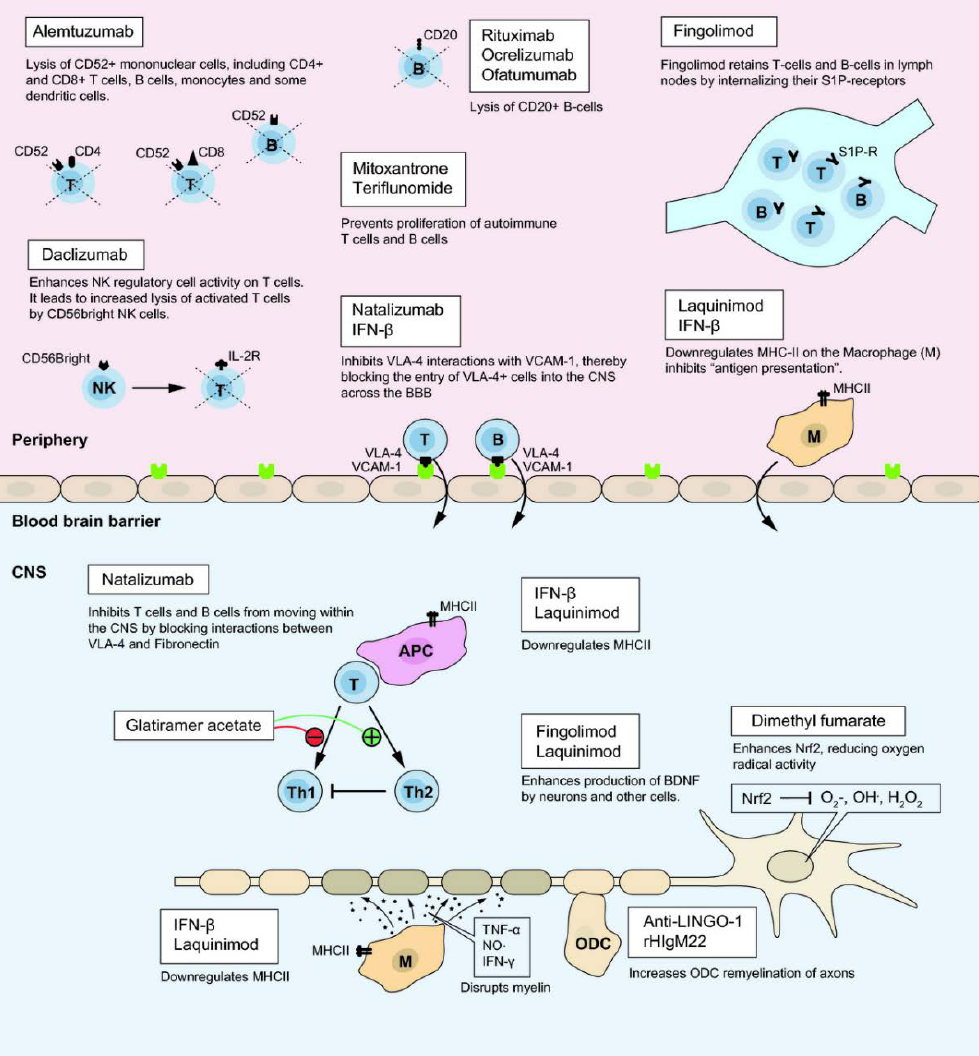
Figure 3. Suggested mechanism of action of several disease-modifying therapies ( DMTs) (with the permission of [47]).